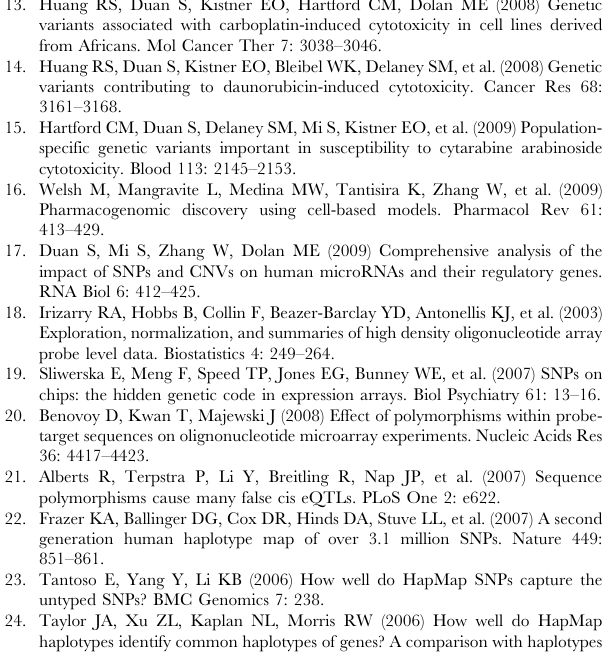
Table S8 The number of probesets containing probes with novel and common SNPs within each transcript cluster (CEU). Table S9 The number of probesets containing probes with novel and common SNPs within each transcript cluster (YRI). Table S10 Probe-level information of probesets containing novel SNPs (CEU). Table S11 Probe-level information of probesets containing novel SNPs (YRI). Table S12 The differentially spliced probesets that could be affected by novel